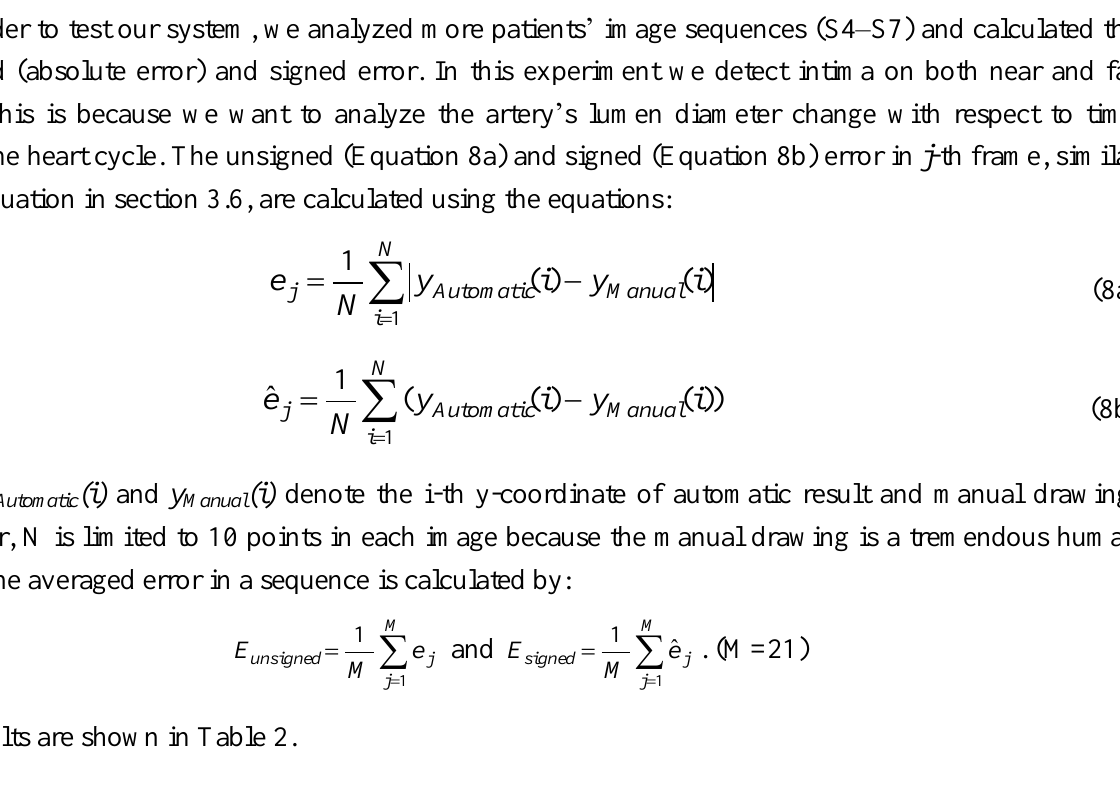
Table 2. Averaged unsigned and signed error. The comparison between automated result and expert’s manual drawing. (1 pixel = 0.106